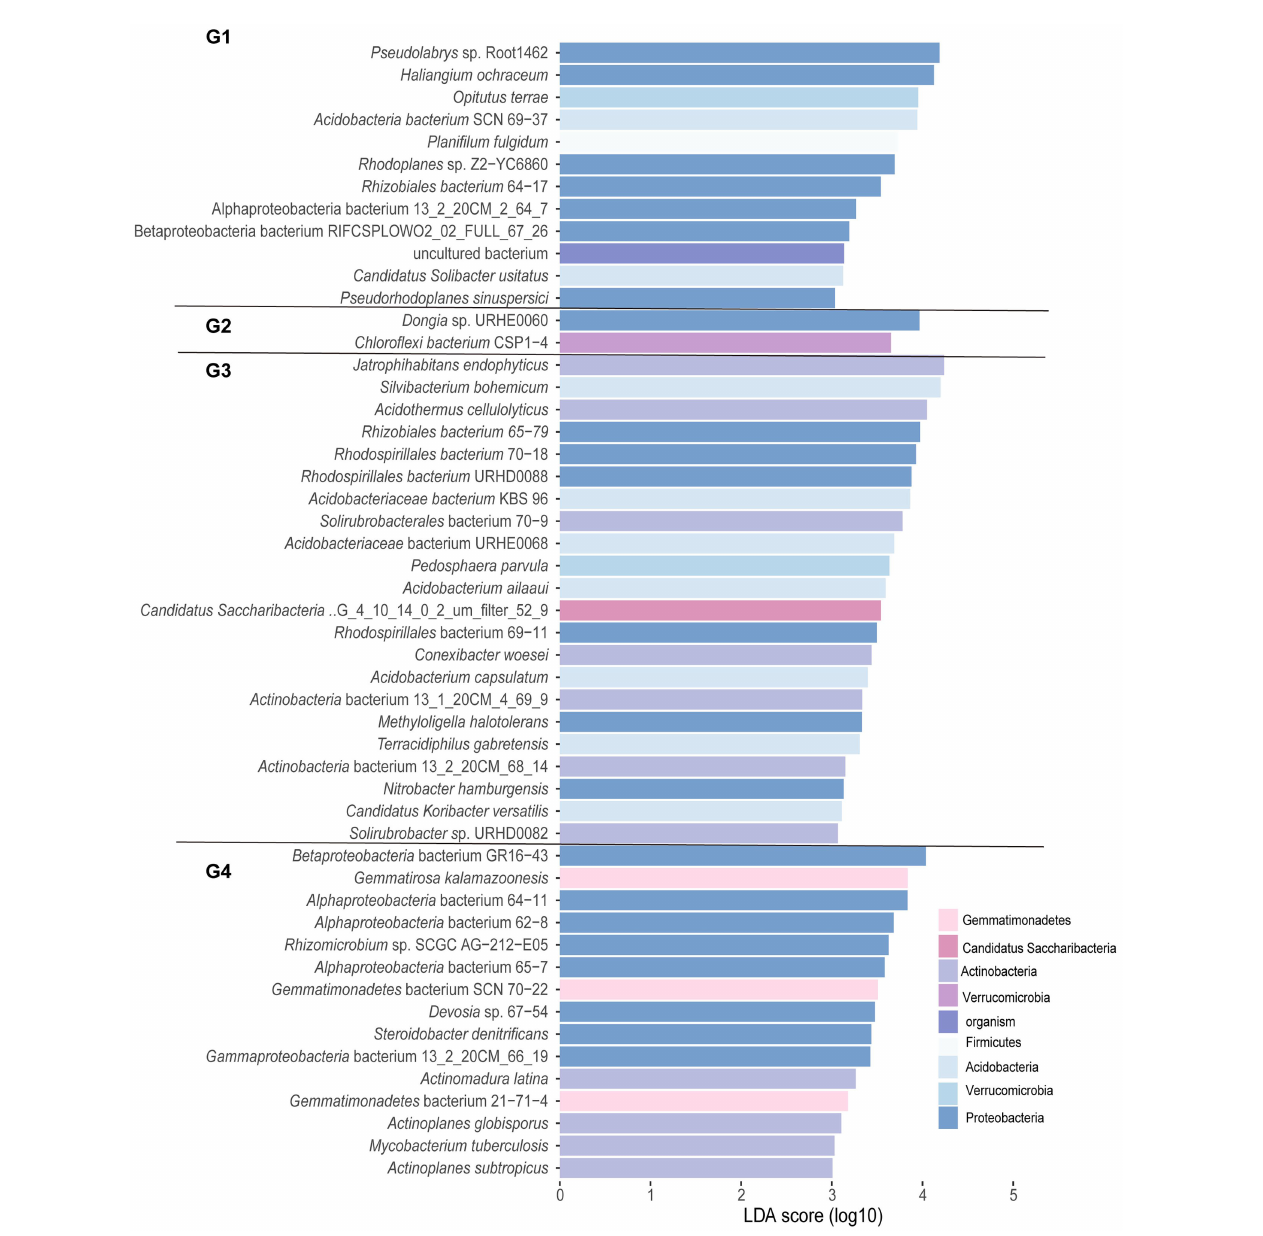
(Figure 4F). In contrast, only one connector ( Opitutaceae bacterium